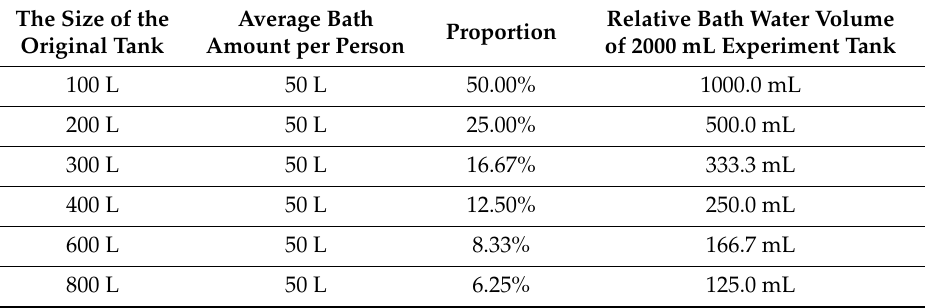
Table 1. The bath water consumption during